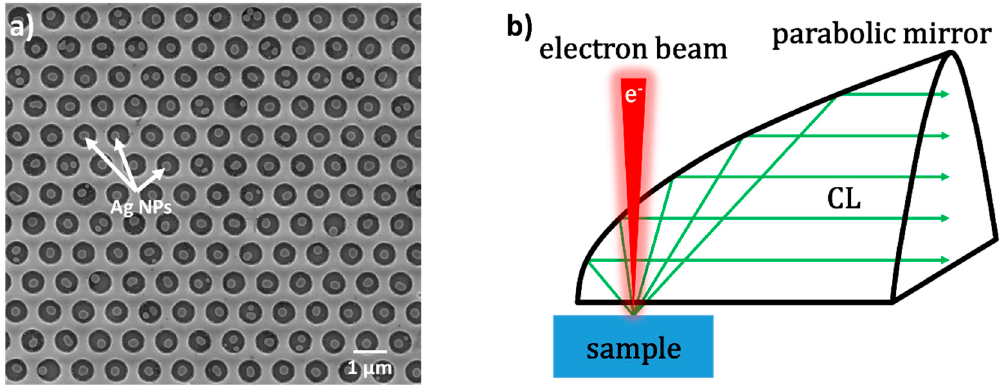
Figure 1. ( a ) Scanning electron microscope (SEM) image of the Ag–photonic crystal (PhC)/quantum well (QW) sample. ( b ) Schematic setup for the cathodoluminescence (CL) measurement.